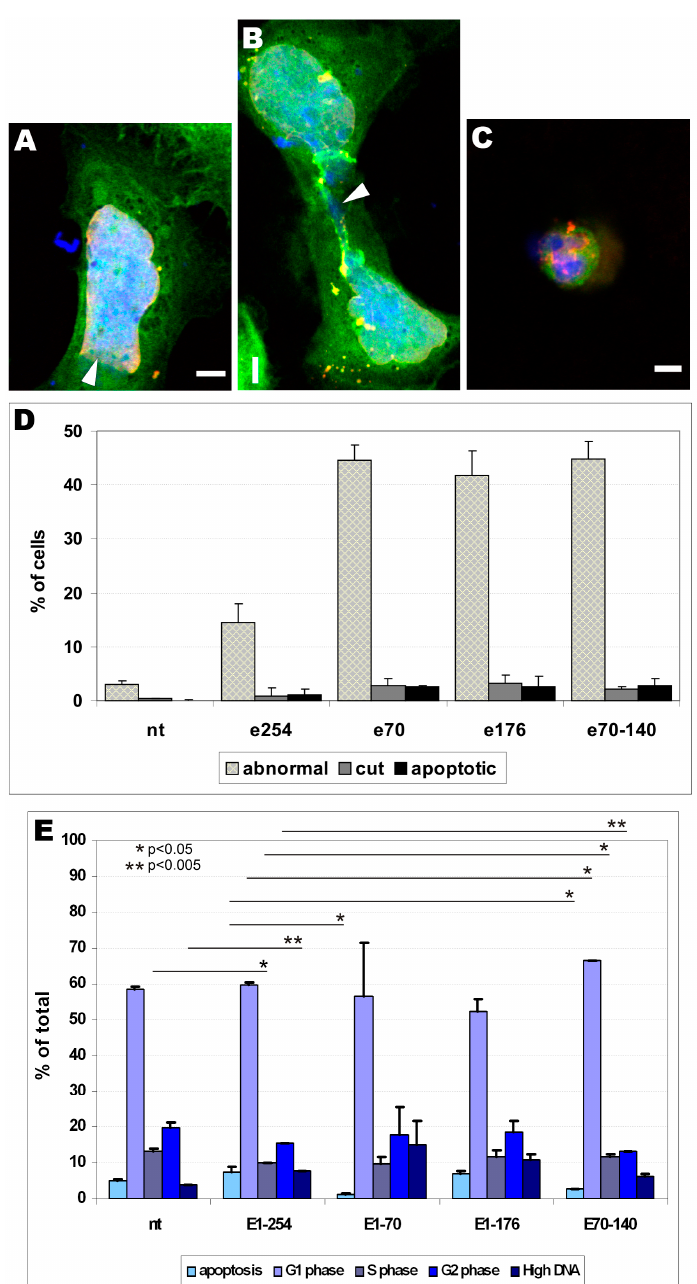
Figure 6. The effect of overexpression of emerin deletion mutants on the HeLa cell phenotype and cell cycle. Overexpression of emerin fragments induces the three most common atypical phenotypes, indicated as abnormal ( A ), “cut” ( B ), and apoptotic ( C ). Cells transfected with GFP-tagged emerin mutant (green) were stained for DNA (blue) and lamins A/C (red). Single confocal sections (1.5 µ m) through the center of cells are shown. Bar, 5 µ m. Only merged images are shown. ( D ) The results of manual counting and statistical analysis of phenotype frequency in untransfected cells (nt) and those transfected with the full-length emerin construct (E254) or emerin mutants (E70, E176, or E70–140). For the abnormal phenotypes, there were statistically significant differences ( t -test < 0.05) between nt and all emerin constructs as well as for E254 and each emerin mutant. For “cut” and apoptotic phenotypes, only frequencies of nt versus all emerin constructs were significantly different. ( E ) Histogram showing cell cycle distribution for untransfected HeLa cells and those transfected with E254, E70, E176, or E70–140 constructs, based on flow cytometry data. Fixed cells were stained for propidium iodide and analyzed using flow cytometry. Apart from G1, S, and G2/M phases, low DNA (apoptotic) and high DNA (polyploidic) fractions also were distinguished. Overall, cells transfected with emerin mutants showed slightly decreased counts in G2/M phase, without increases in apoptotic